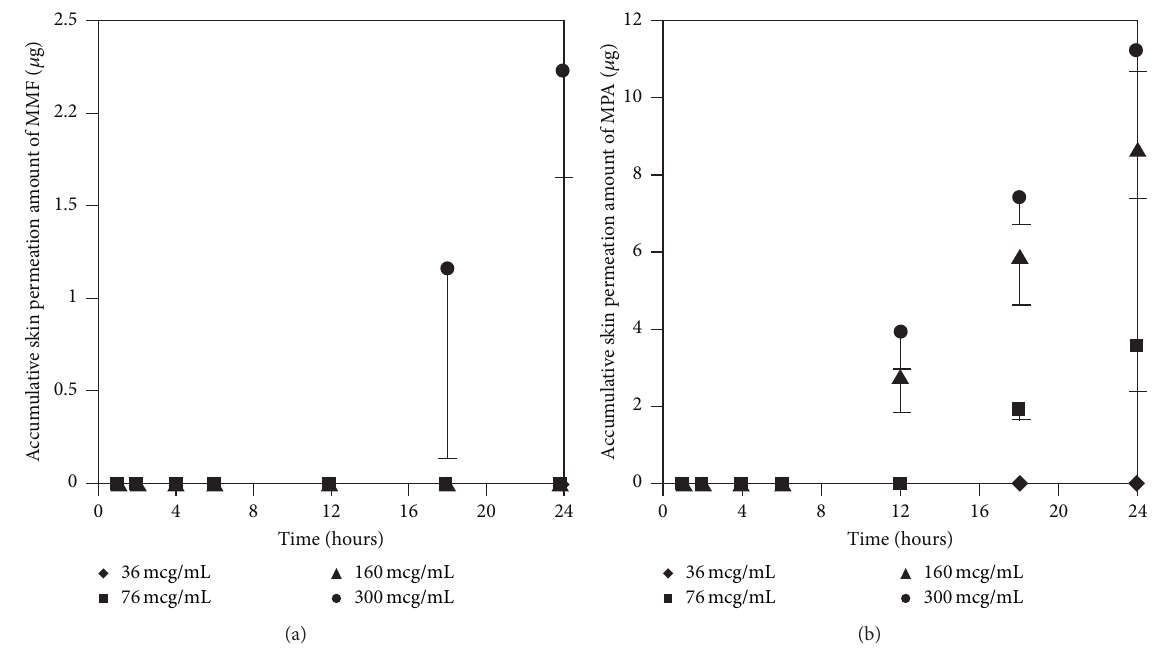
Figure 4: Skin permeation profiles of MMF (a) and MPA (b) at various concentrations of MMF preparation (36, 76, 160, and 300 𝜇 g/mL).